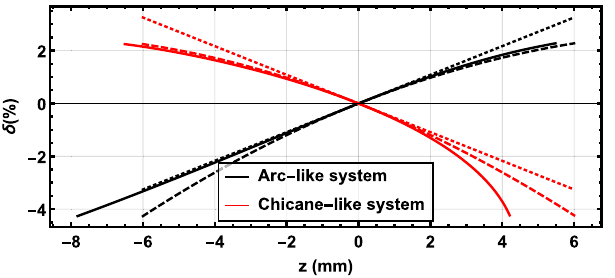
FIG. 2. Longitudinal phase space of chirped bunches for compression in an arclike system (black) and chicanelike (red). Ideal “ linear ” bunch (dotted), with curvature from the fundamental rf (dashed) and effect of negative T 566 (solid) shown. We see that the curvature is exacerbated in the chicanelike system, and alleviated in the arclike